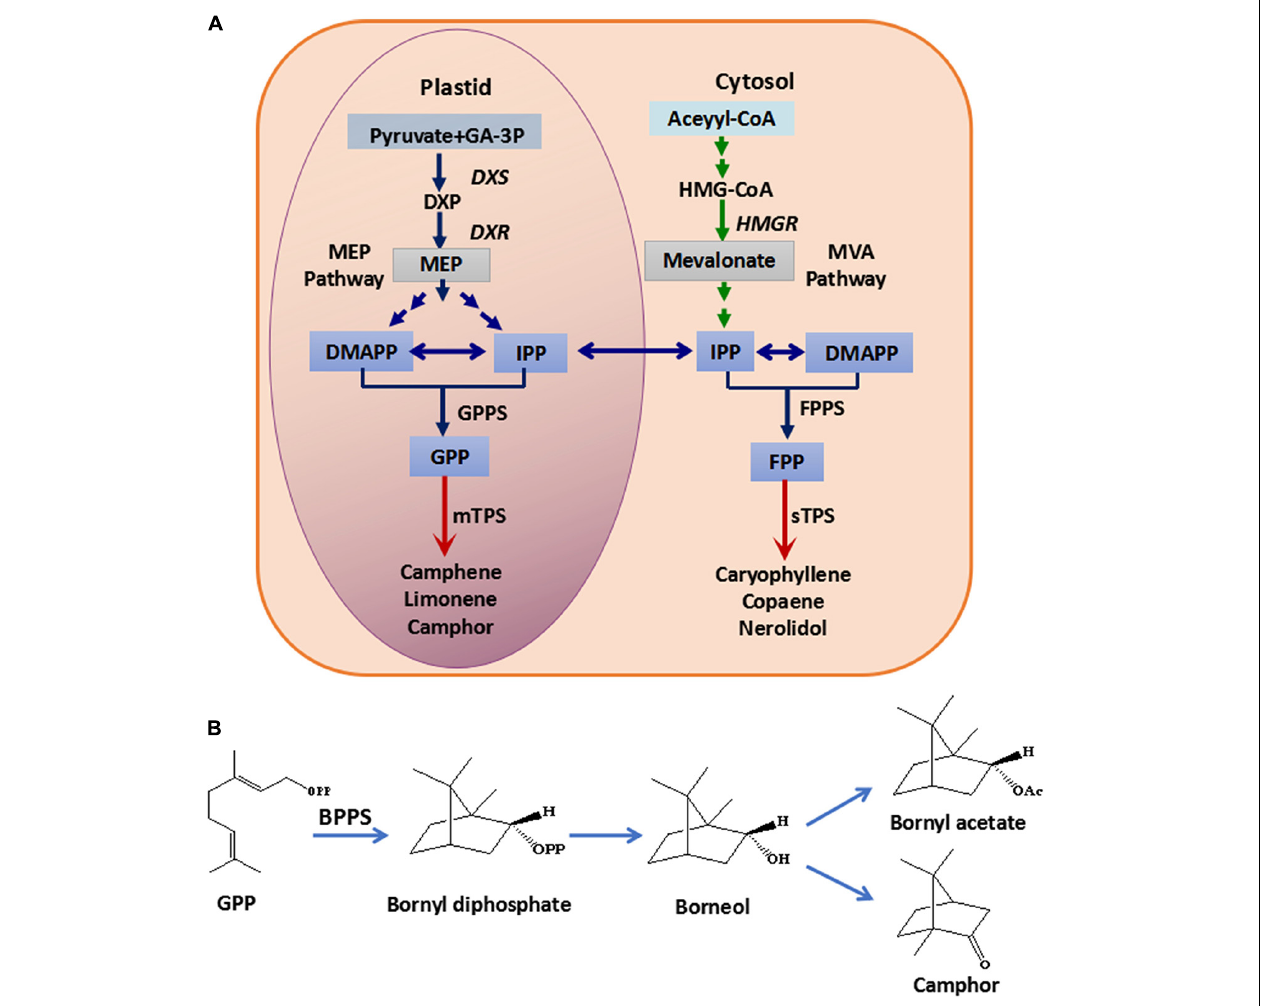
FIGURE 1 | Monoterpenoid and sesquiterpenoid biosynthesis pathway (A) and the biosynthesis pathway from GPP to borneol, camphor and bornyl acetate (B) . GA-3P, glyceraldehyde-3-phosphate; HMG-CoA, 3-hydroxy-3-methylglutaryl coenzyme A; DXS, 1-deoxy-D-xylulose-5-phosphate synthase; DXP, 1-deoxy-D-xylulose-5-phosphate; DXR, 1-deoxy-D-xylulose-5-phosphate reductoisomerase; HMGR, 3-hydroxy-3-methyl glutaryl coenzyme A reductase; DMAPP, dimethylallyl diphosphate; IPP, isopentenyl diphosphate; MEP, 2-C-methyl-D-erythritol-4-phosphate; MVA, mevalonic acid; GPPS, geranyl diphosphate synthase; GPP, geranyl diphosphate; FPPS, farnesyl diphosphate synthase; FPP, farnesyl diphosphate; mTPS, monoterpenoid synthase; sTPS, sesquiterpenoid synthase; BPPS, bornyl diphosphate